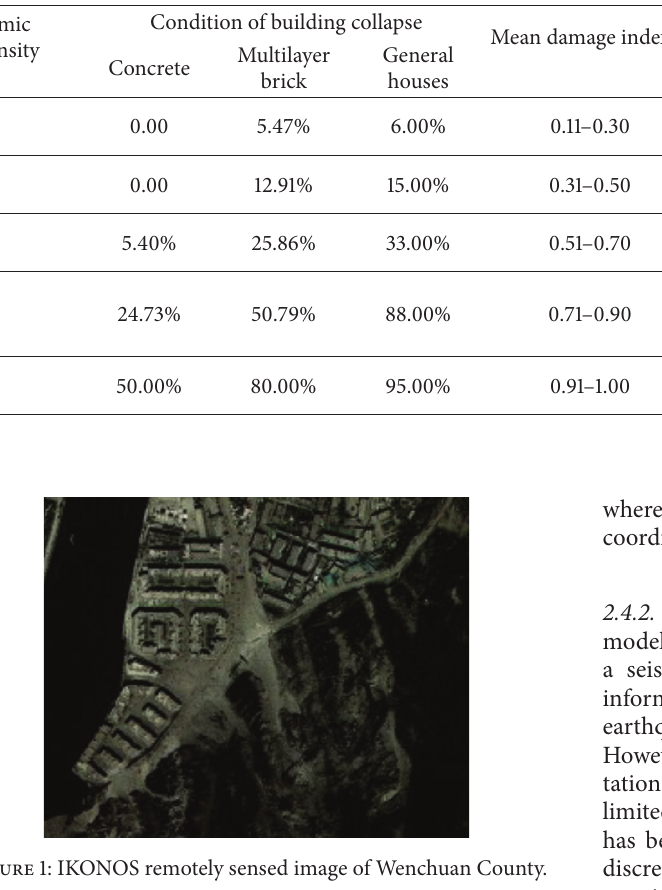
difficult to identify these damaged houses. So intensity values in Table 1 are all above